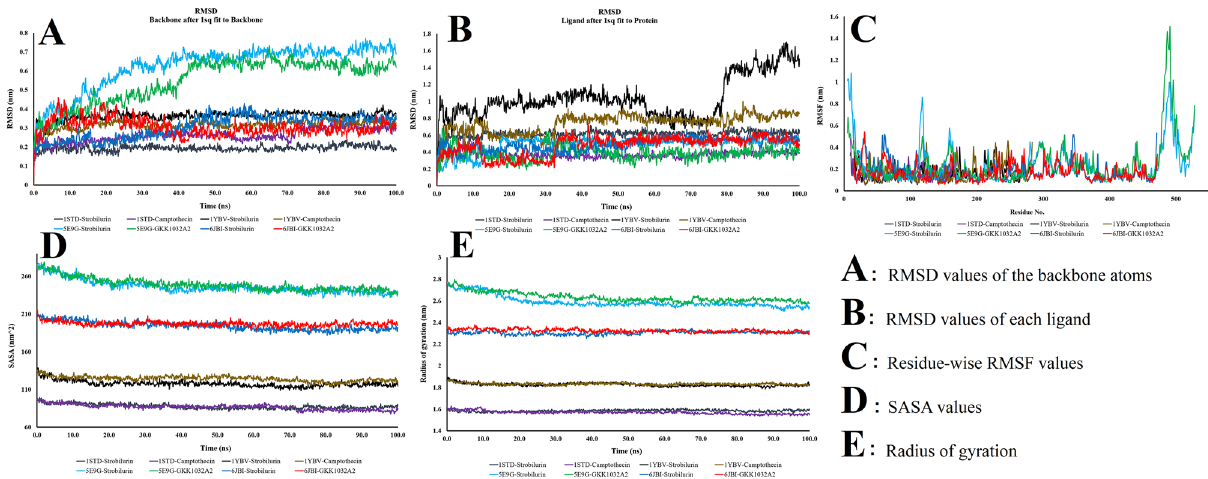
Figure 5. Molecular dynamics simulation of the protein-ligand complexes. ( A ) RMSD values of the backbone atoms, ( B ) RMSD values of each ligand, ( C ) residue-wise RMSF values, ( D ) SASA values, and ( E ) radius of gyration